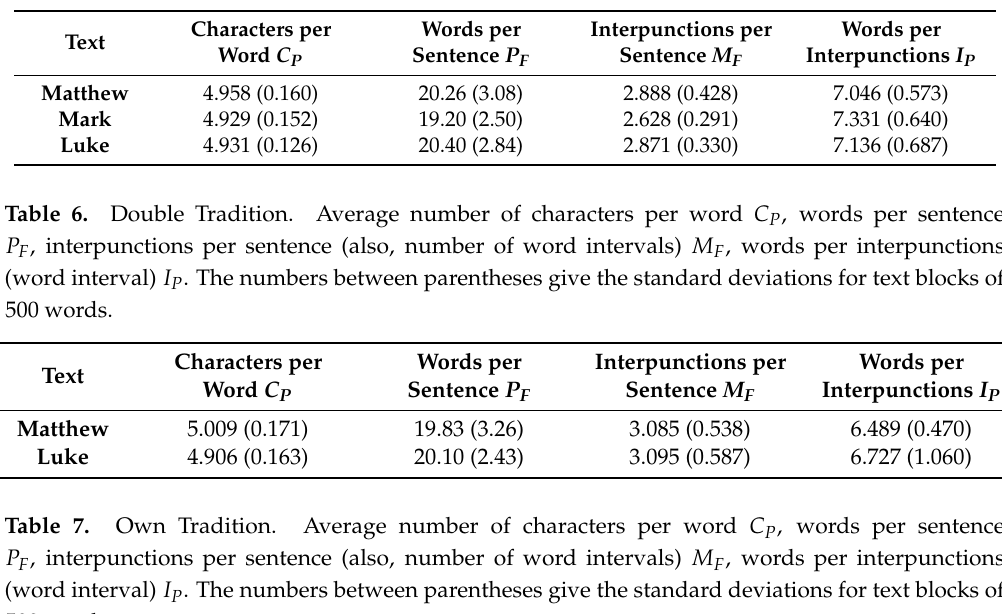
Table 5. Triple Tradition. Average number of characters per word C P , words per sentence P F , interpunctions per sentence (also, number of word intervals) M F , words per interpunctions (word interval) I P . The numbers between parentheses give the standard deviations for text blocks of 500 words.